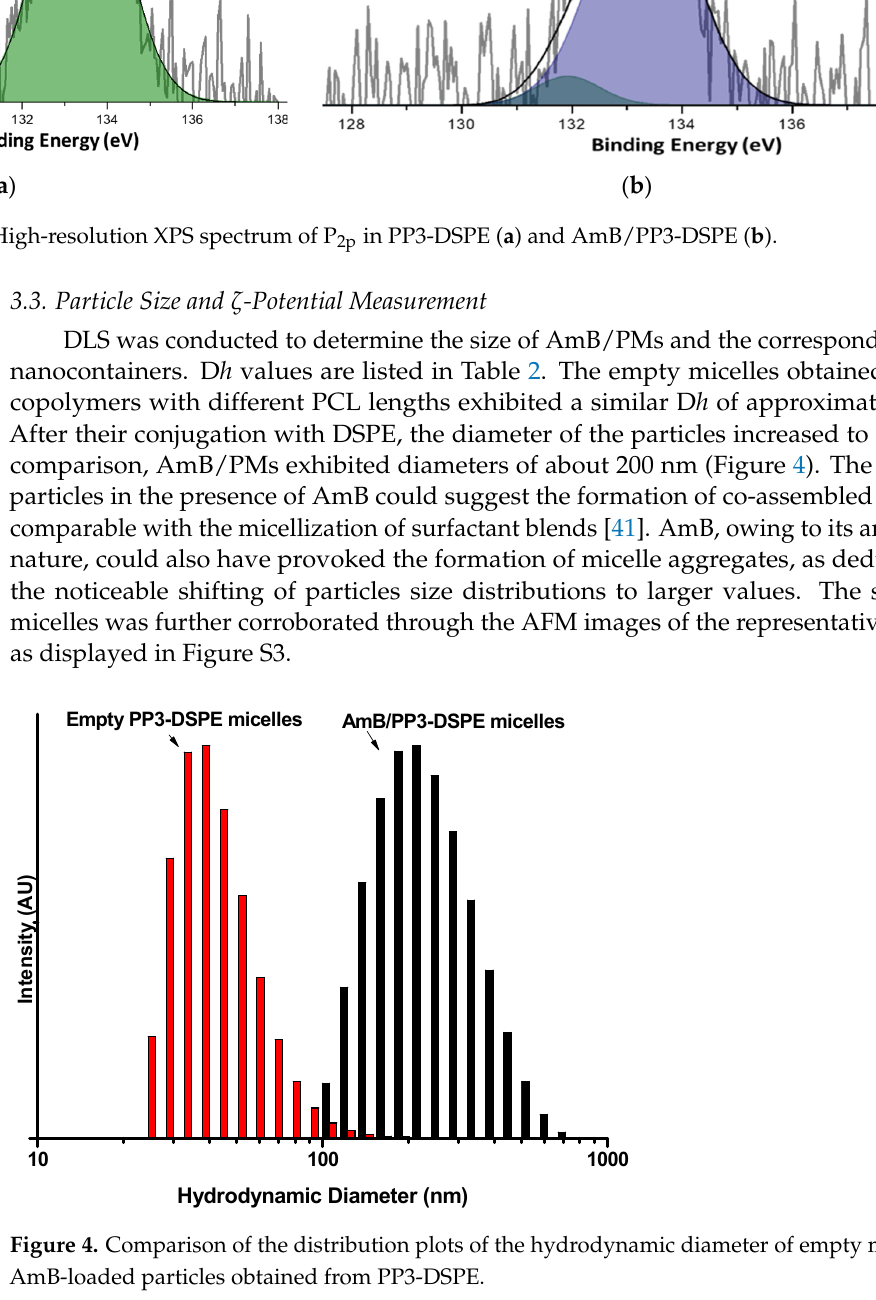
Figure 3. High-resolution XPS spectrum of P 2p in PP3-DSPE ( a ) and AmB/PP3-DSPE ( b ).